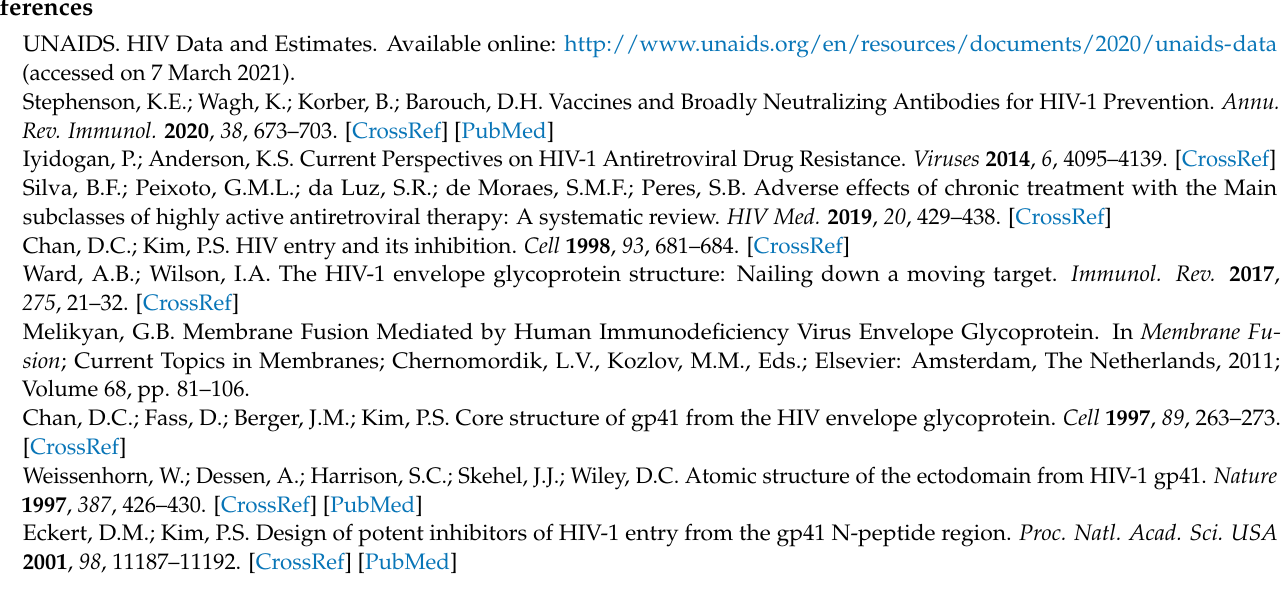
thermograms; Figure S3: ITC displacement experiment; Figure S4: In vitro inhibition assays; Table S1: Amino acid sequences of the covNHR proteins; Table S2: Thermodynamic and kinetic parameters of thermal unfolding; Table S3: Apparent hydrodynamic radii of the covNHR